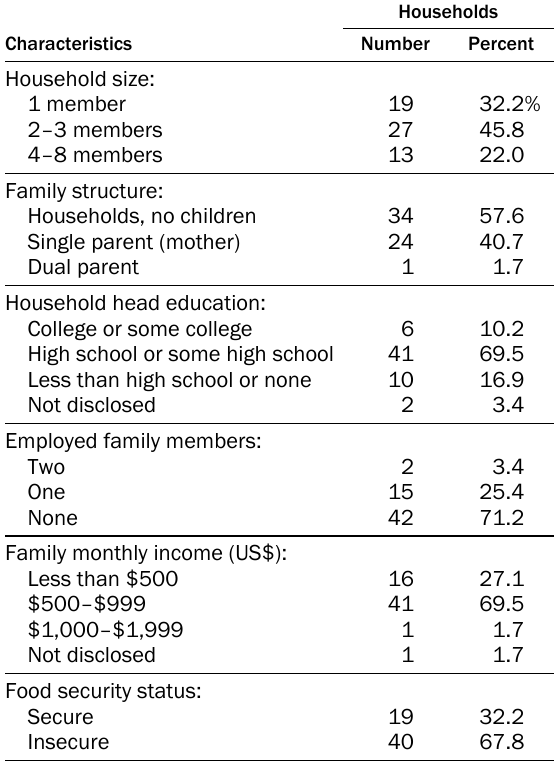
Table 1. Basic Characteristics of the Coping Strategies Study